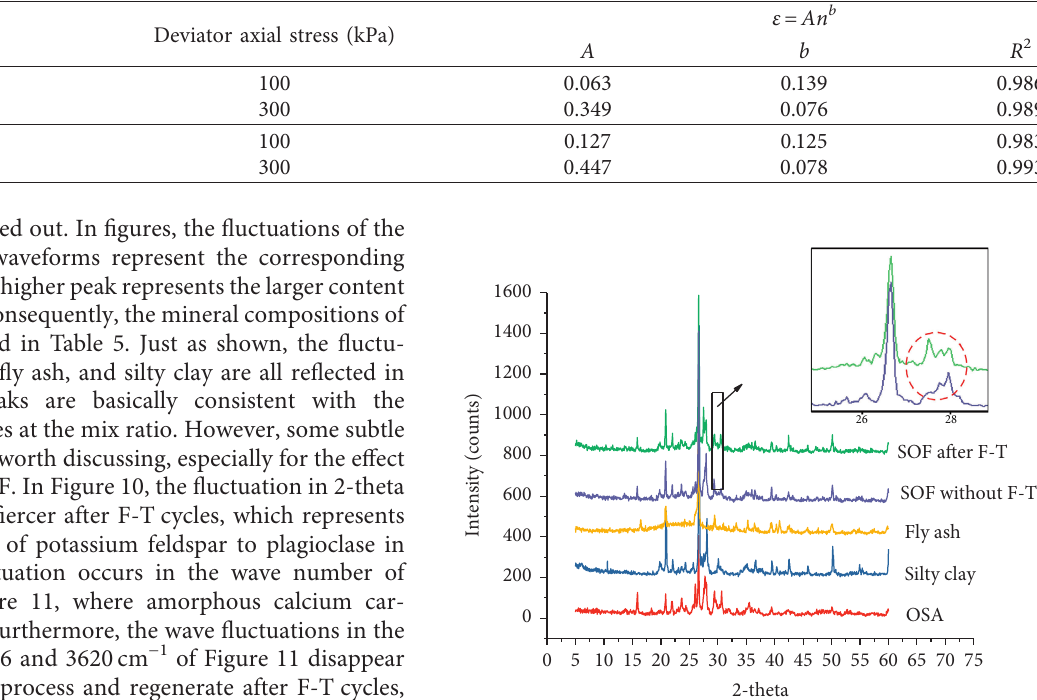
Figure 9: Detailed deformation curve of SOF during the first 10 cyclic vibrations. Table 4: Fitting results of long-term deformation prediction model.